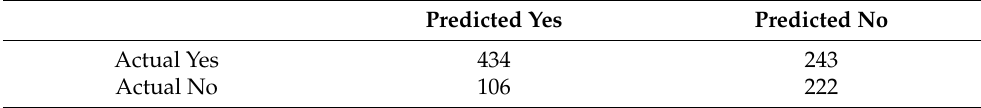
Table 6. Naive Bayes confusion